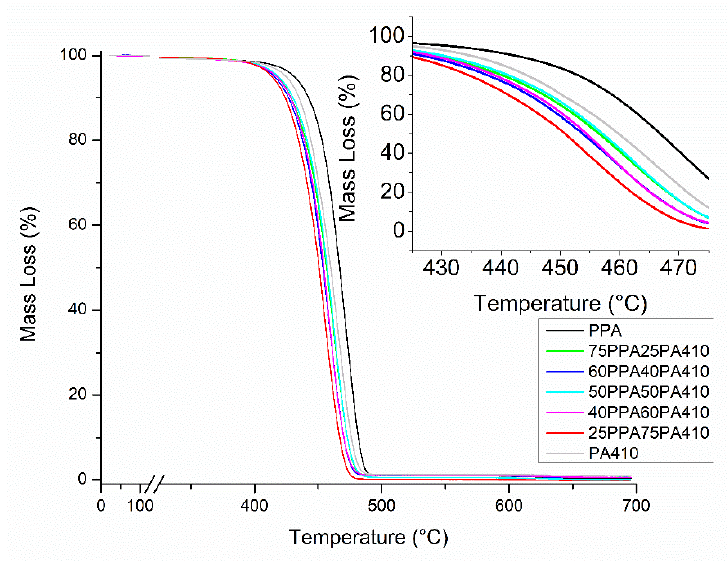
Figure 4. TGA curves of neat polymers and the prepared blends